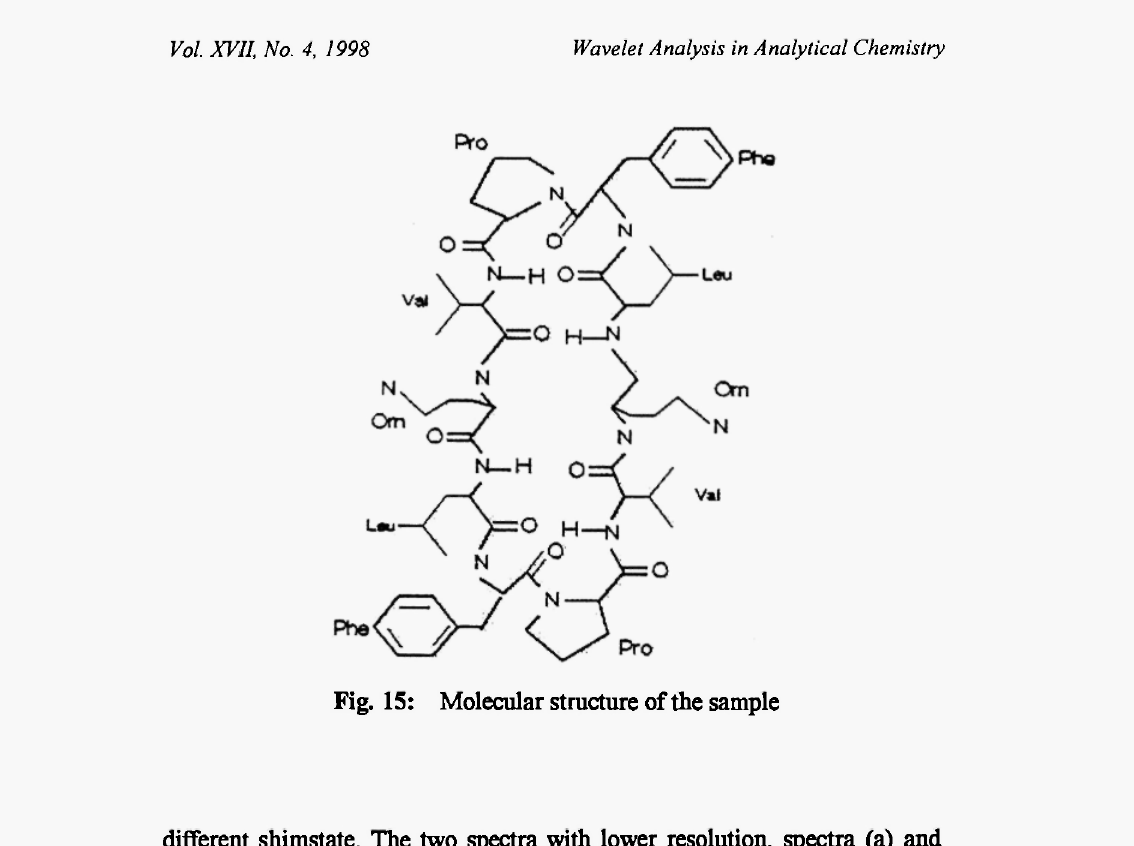
Fig. 15: Molecular structure of the